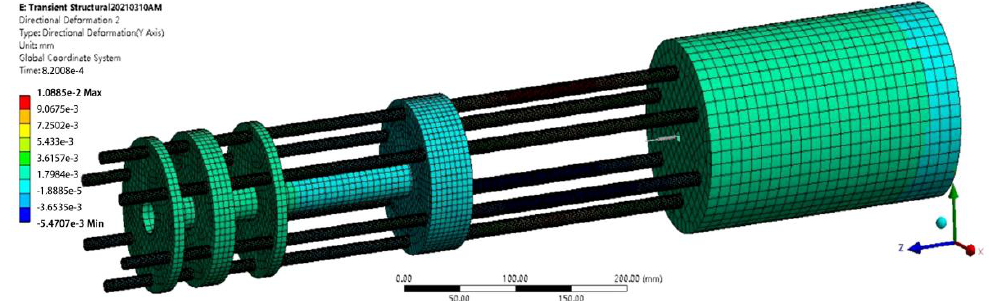
Figure 14. The Y (vertical) displacement.